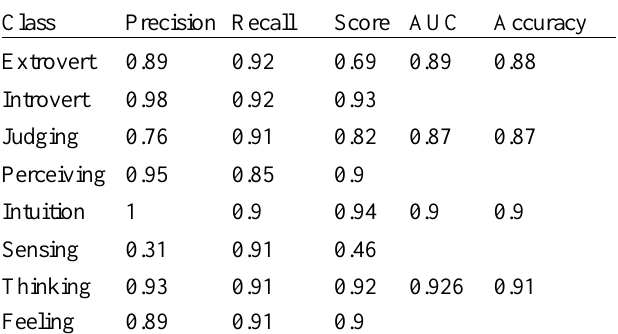
Logistic regression result with basic feature